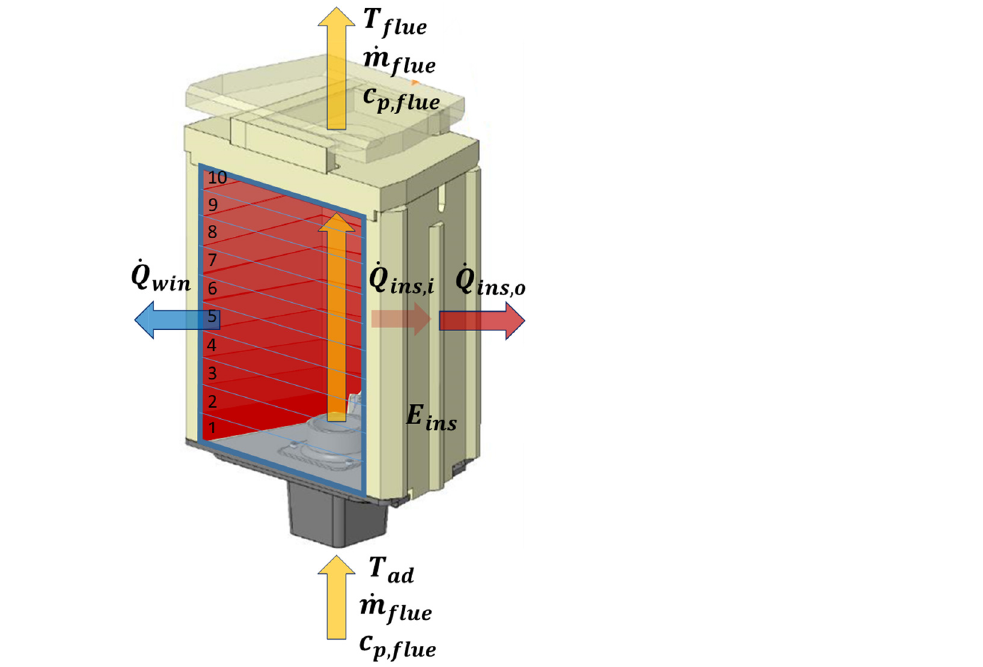
Figure 6. Energy and mass balance of the combustion chamber.